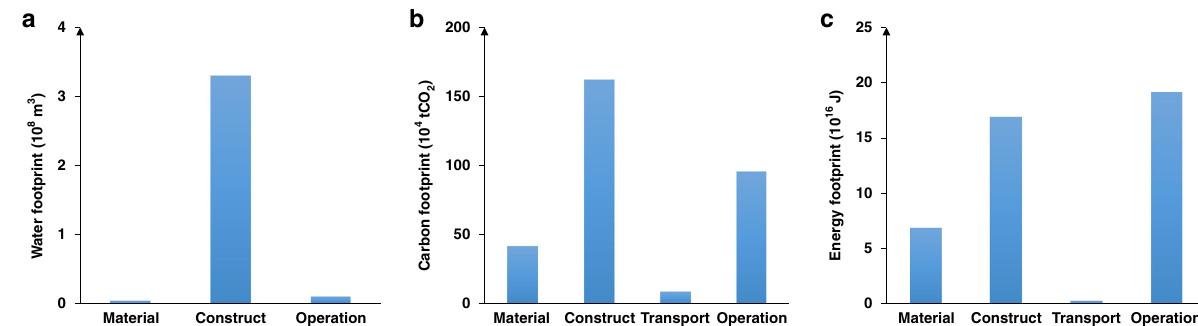
Fig. 4 Water footprint, carbon footprint, and energy footprint at each stage of the South-to-North Water Transfer Project ’ s life cycle. a Water footprint; b carbon footprint; c energy footprint. Data are provided in the Source data fi